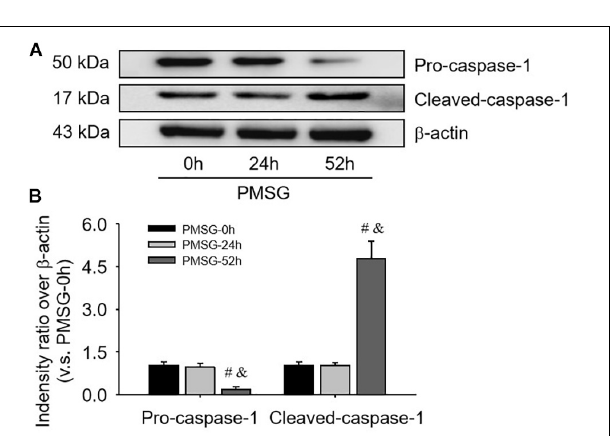
(ANOVA) was used to analyze the data, followed by a Tukey’s multiple range